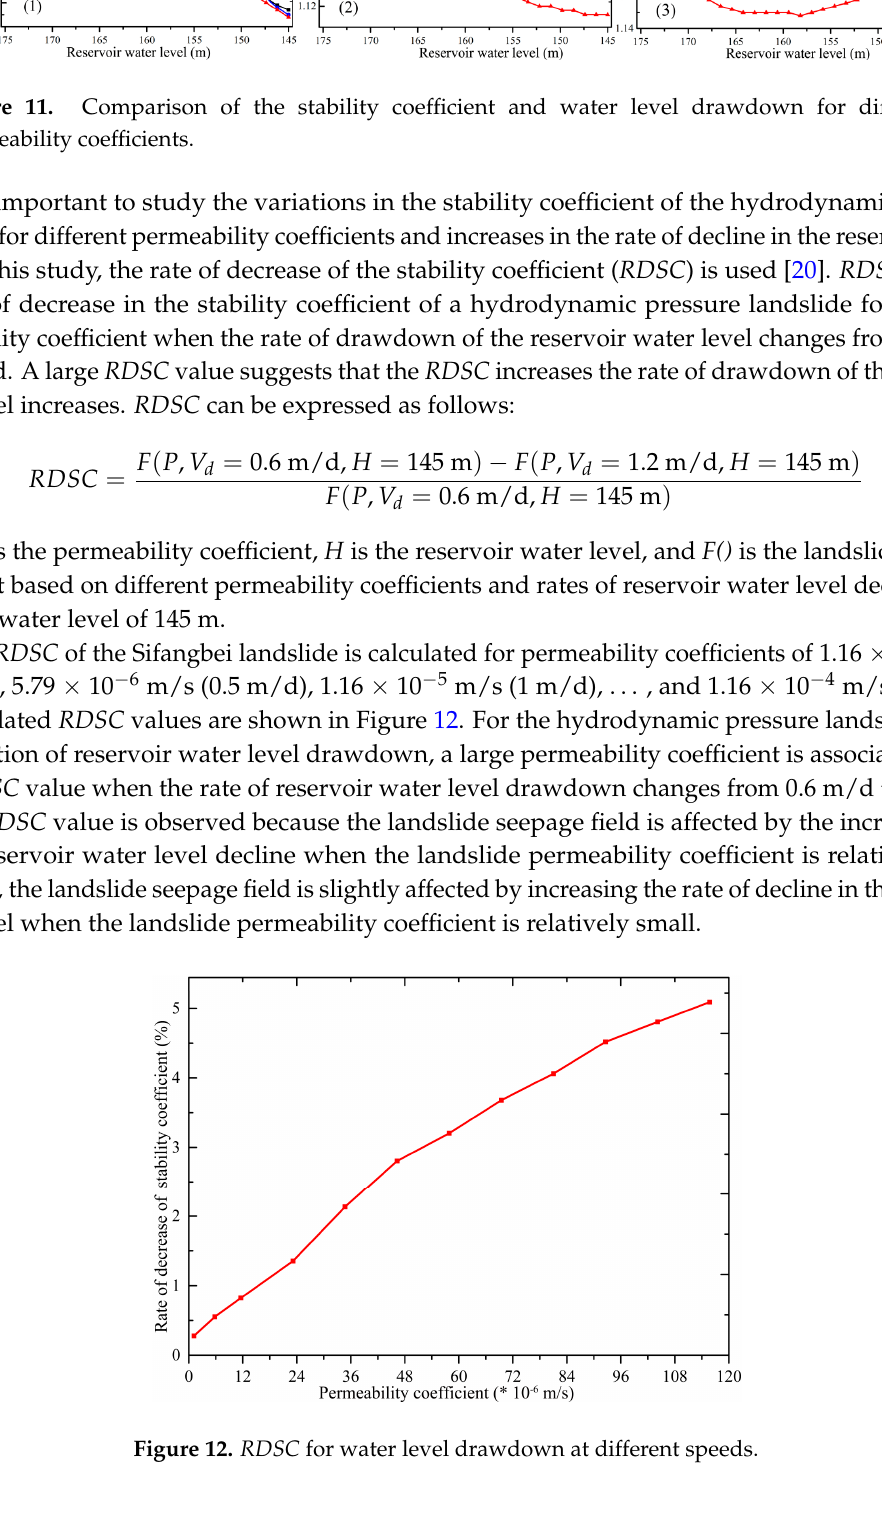
Figure 12. RDSC for water level drawdown at different speeds.